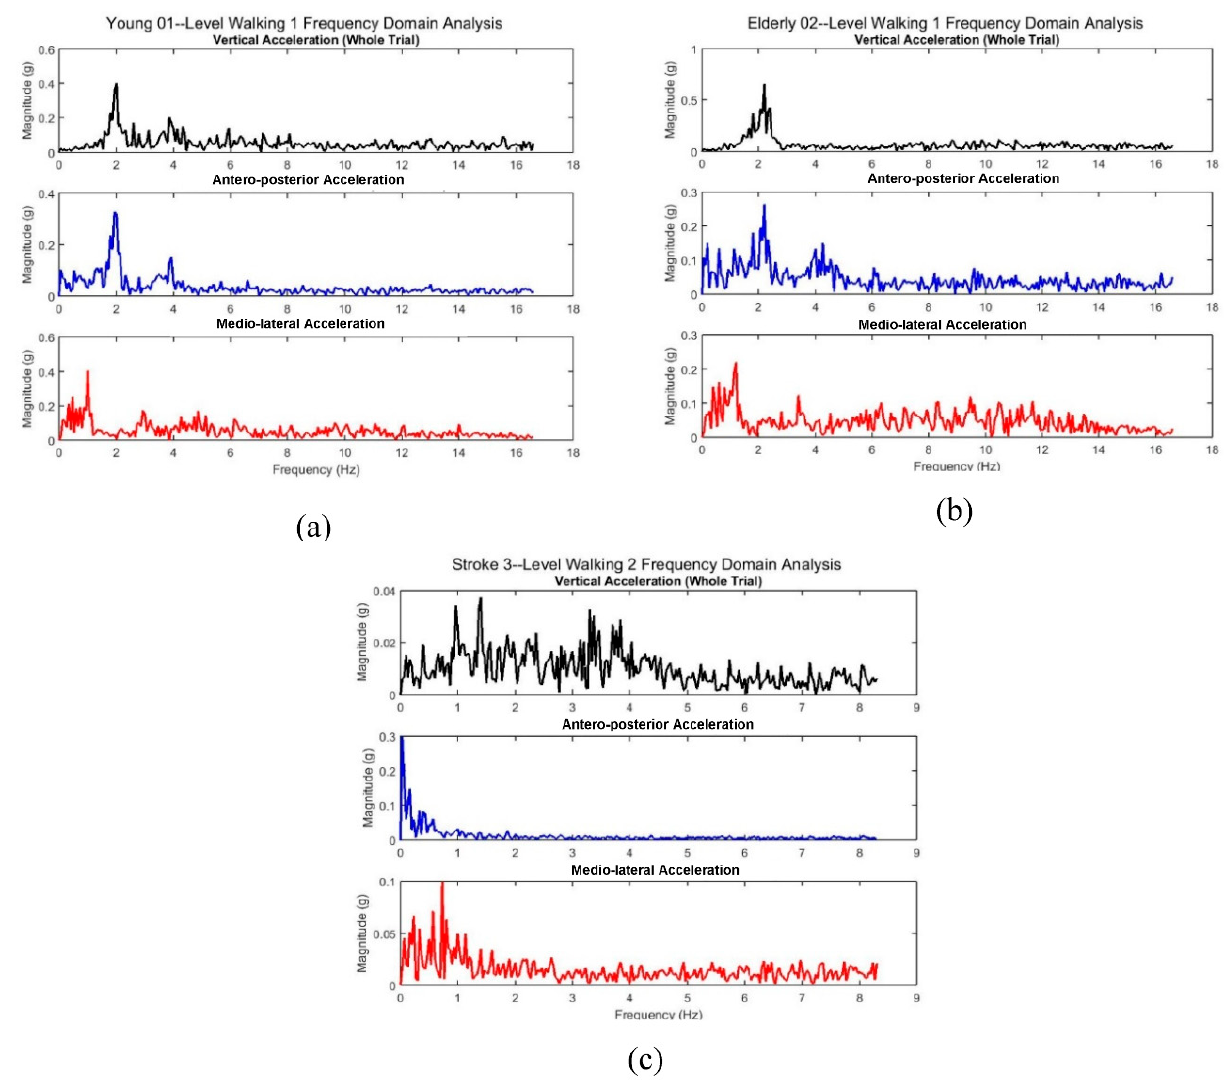
Figure 3. Frequency domain characteristic of acceleration from young ( a ), elderly ( b ), and stroke ( c ) subjects on three different directions.